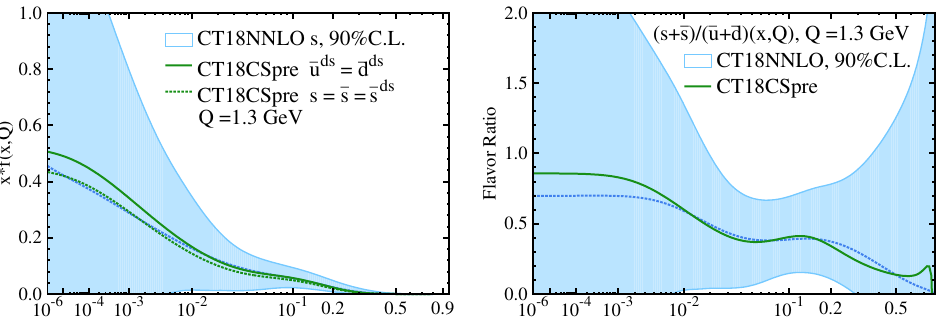
Figure 3: Similar to Fig. 2, but for the DS components of ¯ u , ¯ d and s distributions. The ratio plot of ( s + ¯ s ) / ( ¯ u + ¯ d ) is also shown on the right panel at Q = 1.3 GeV. For CT18CSpre, ¯ u and ¯ d include both the CS and DS components, while s only has DS component.